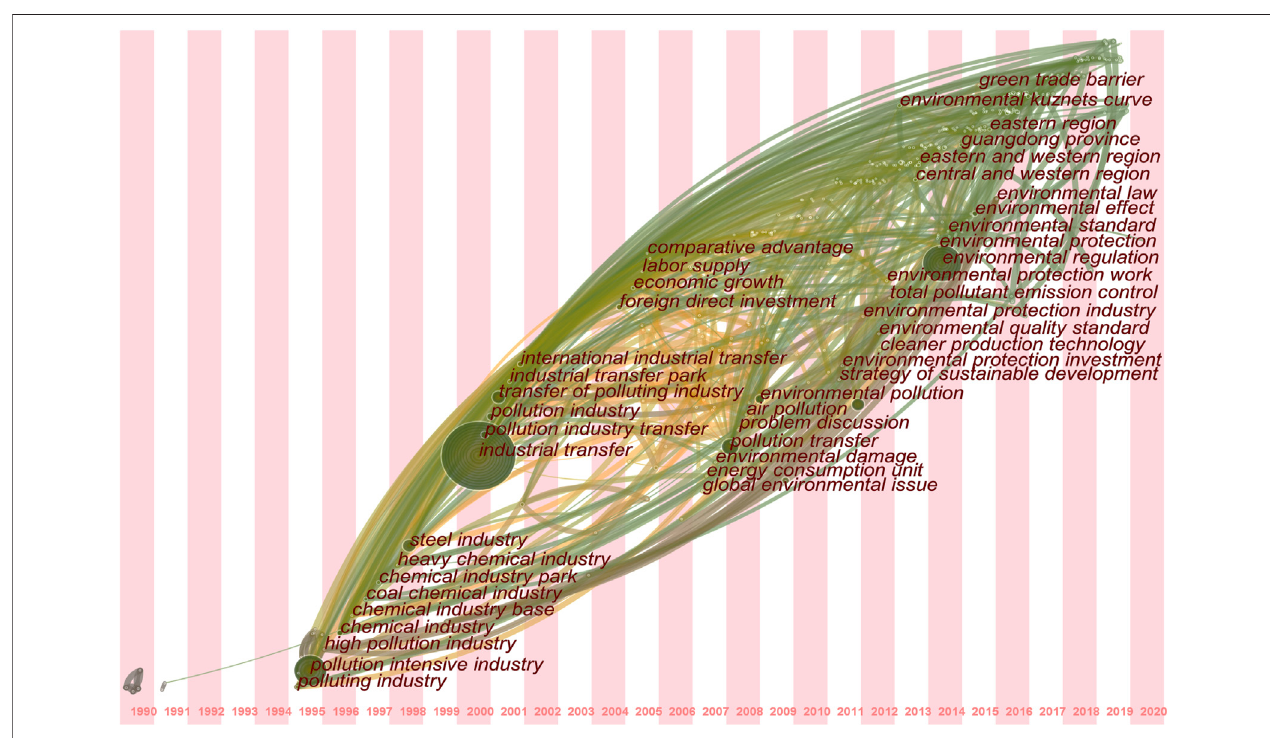
FIGURE 3 | The transfer time zone of pollution-intensive